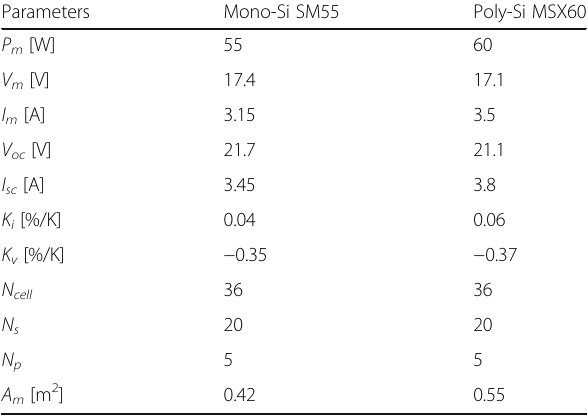
Table 1 Evaluation data and result (portion) Parameters